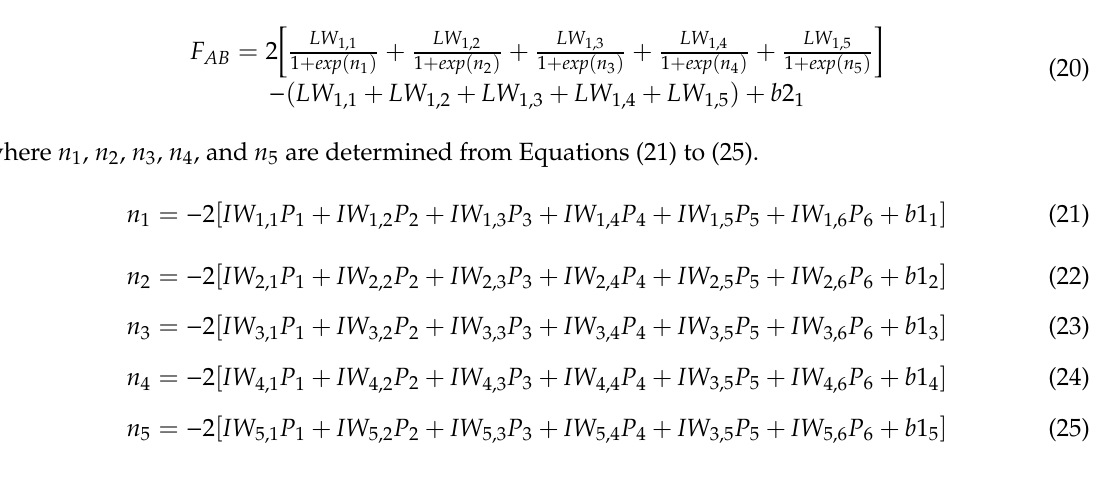
Table 3. Weights and biases of the artificial neural